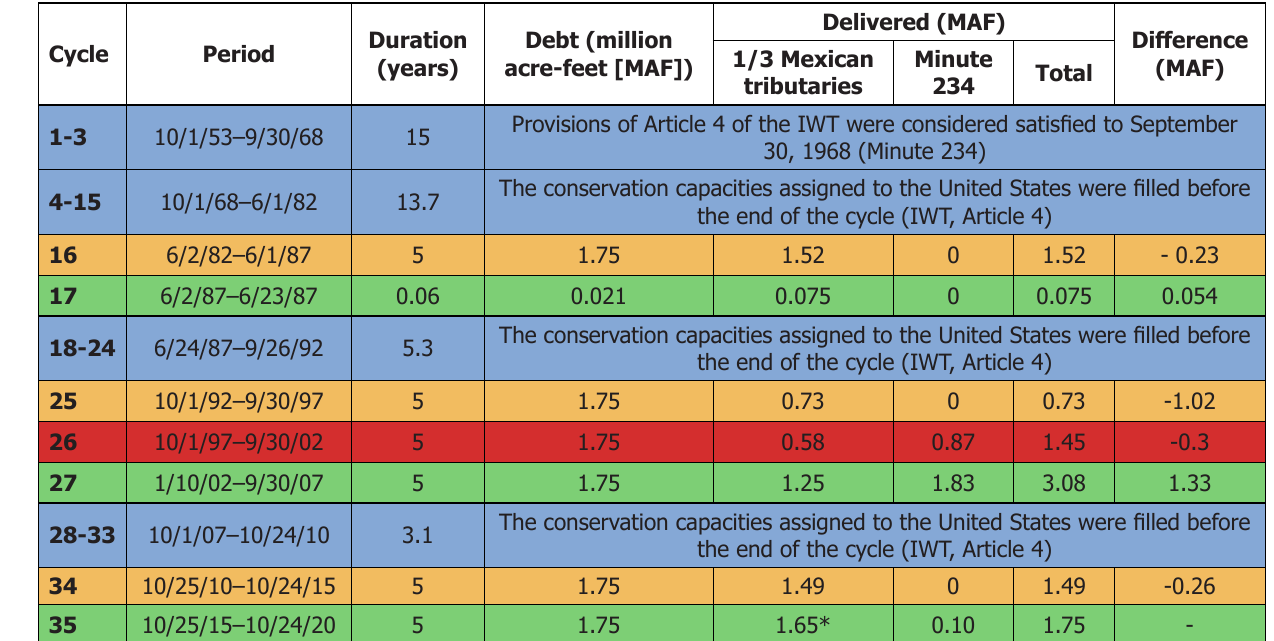
Table 6. Water delivery cycles to the United States in the Rio Grande.